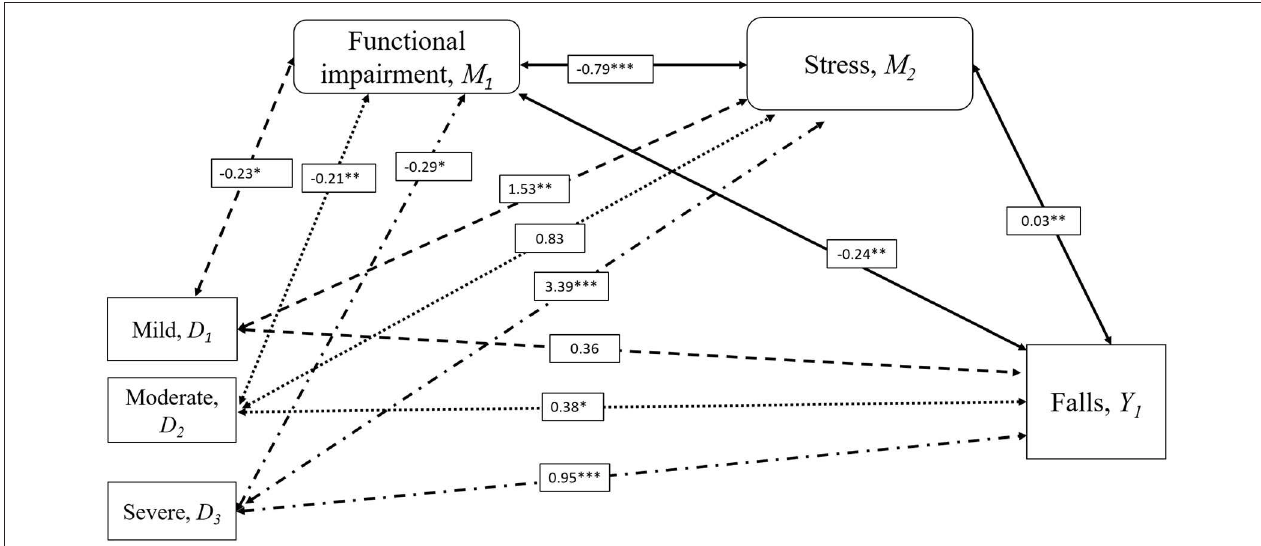
FIGURE 2 | Mediation Analysis for the Influence of Stress on Falls and Knee Pain Severity. Serial multiple mediation analysis with bootstrapping compared to severity of knee pain with falls risk adjusted for age, sex, diabetes, incontinence, and visual impairment. Moderate (D 2 ) and severe knee pain (D 3 ) was associated with a history of falls in the past 12 months (Y 1 ), but not mild knee pain (D 1 ) compared to the individuals with no knee pain. Increased risk of falls in moderate and severe knee pain were mediated by stress (M 2 ) resulting from functional impairment (M 1 ). Significance indicated by * p < 0.05, ** p < 0.01, *** p < 0.001. Numbers were standardized β coefficients. IADL scores were used to represent functional impairment.